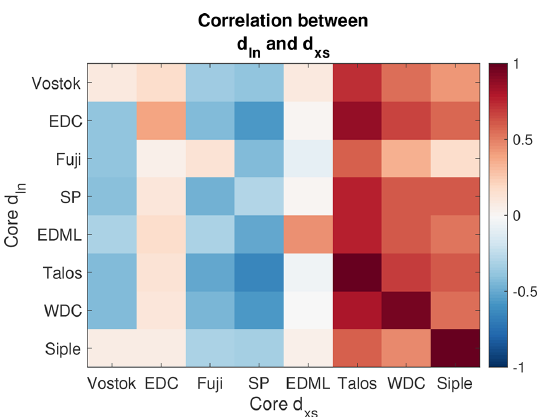
Figure A24. Correlation matrix between d xs and d ln between all core sites. All records are ordered by their approximate modern sur- face